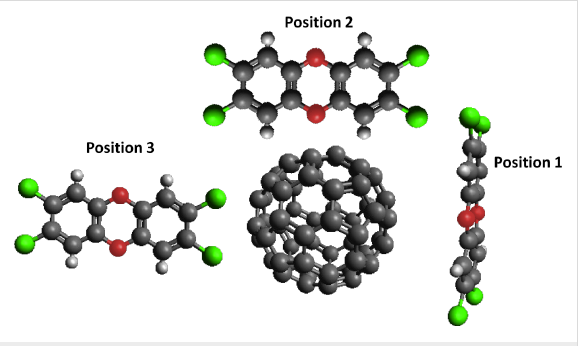
Figure 4: Considered positions of the potential interaction between a fullerene and 2,3,7,8-tetrachlorodibenzo- p -dioxin